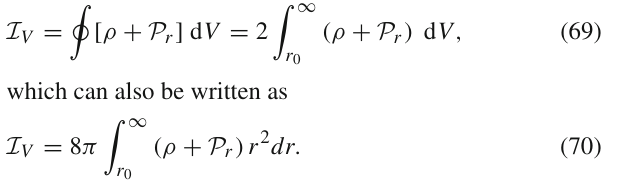
then I V → 0, also. 0